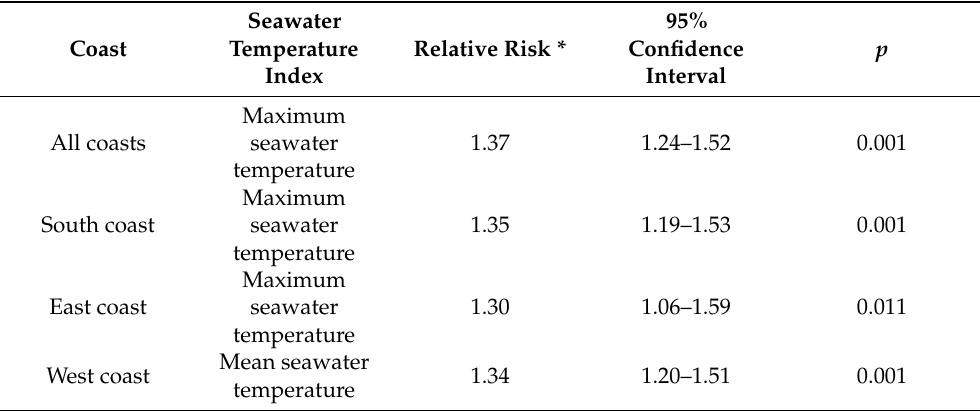
Table 4. Relative risk of V. vulnificus